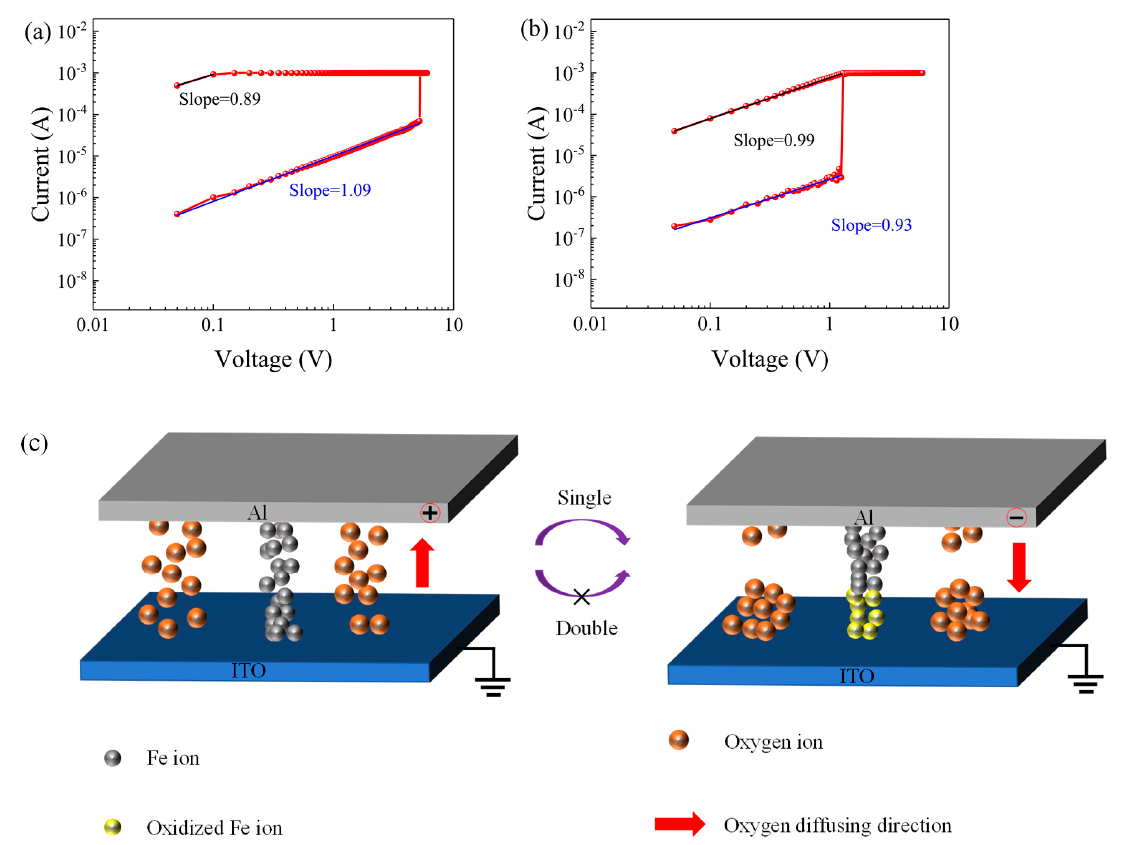
Figure 5. Log-log fits of the I–V curves at a positive bias: ( a ) compliance current in a positive scan. ( b ) compliance current in both a positive and negative scan. ( c ) schematic diagram of the resistance switching mechanism.